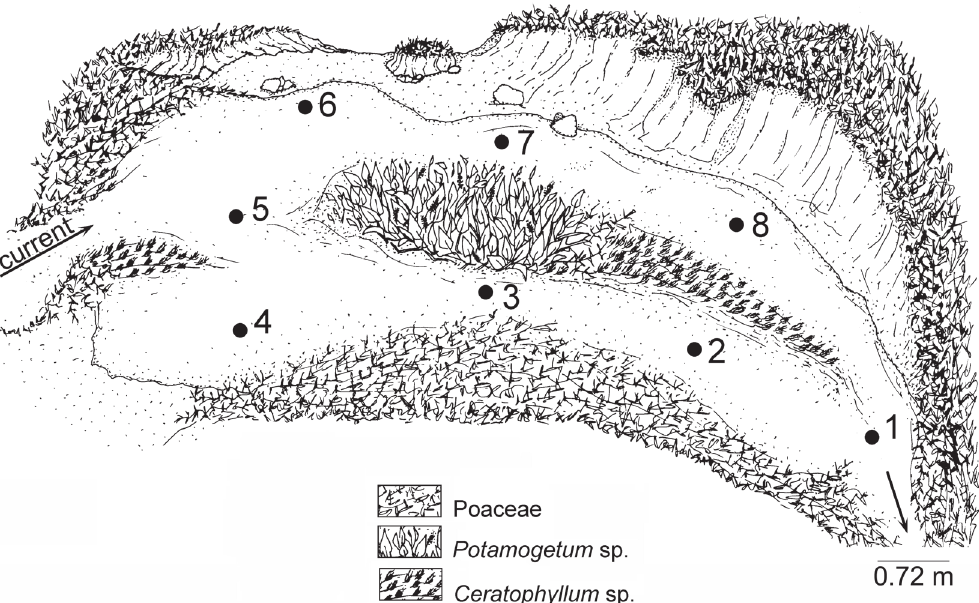
Figure 1. Outline drawing of the studied site in northwestern São Paulo State, showing points where underwater observations were conducted (1-8) and plants contacting water predominant